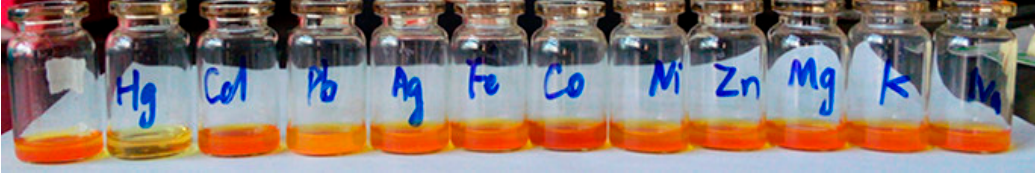
Figure 9. The response of coordination compound Ir1 acetonitrile solution to various metal ions (Hg 2+ , Cd 2+ , Pb 2+ , Ag + , Fe 2+ , Co 2+ , Ni 2+ , Zn 2+ , Mg 2+ , Na + and K + ).